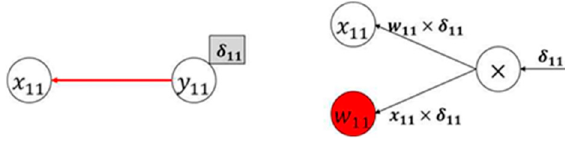
Figure 11. Karpathy calculation graph of x (cid:2869)(cid:2869) backpropagation.